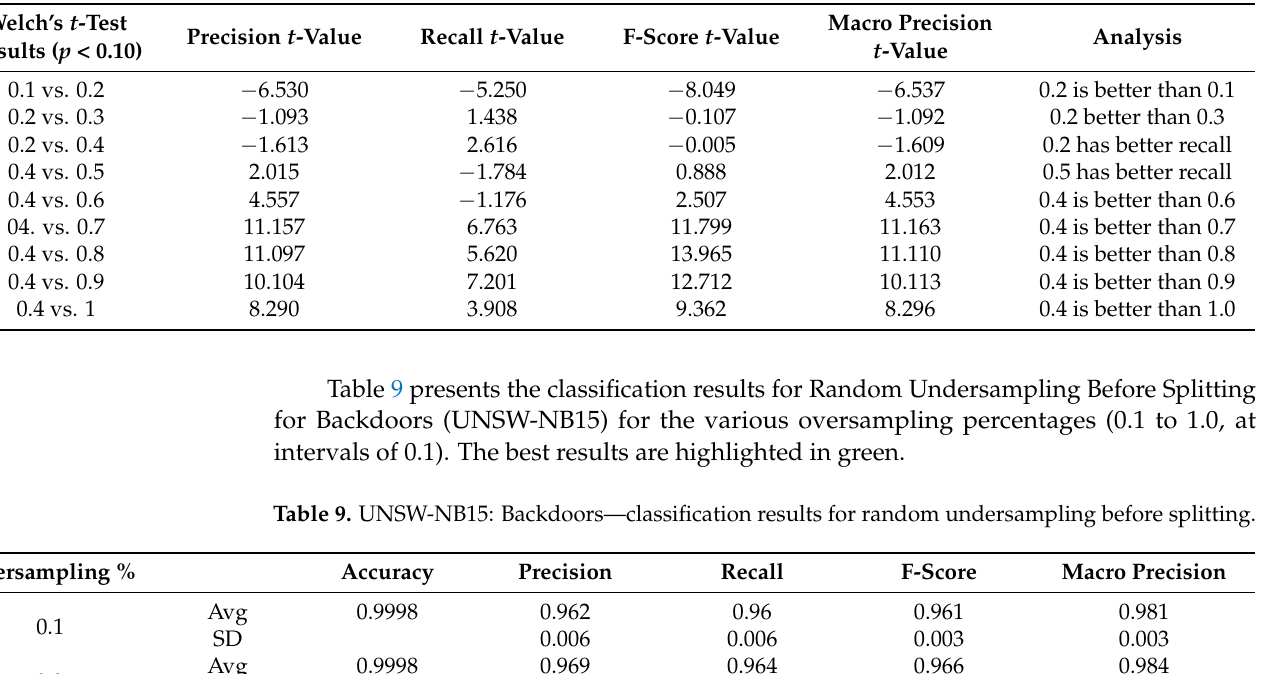
Table 8. Welch’s t -test results: UNSW-NB15: Shellcode—random undersampling before splitting.